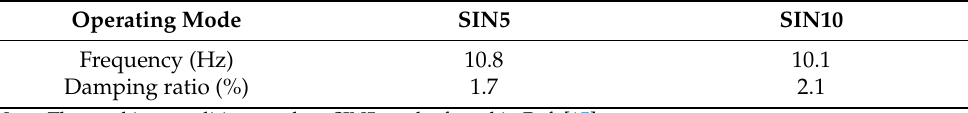
Figure 13. Acceleration peak spectrum curve at point A1 for the case of sinusoidal excitation. Table 6. Identified system frequency and damping ratio.